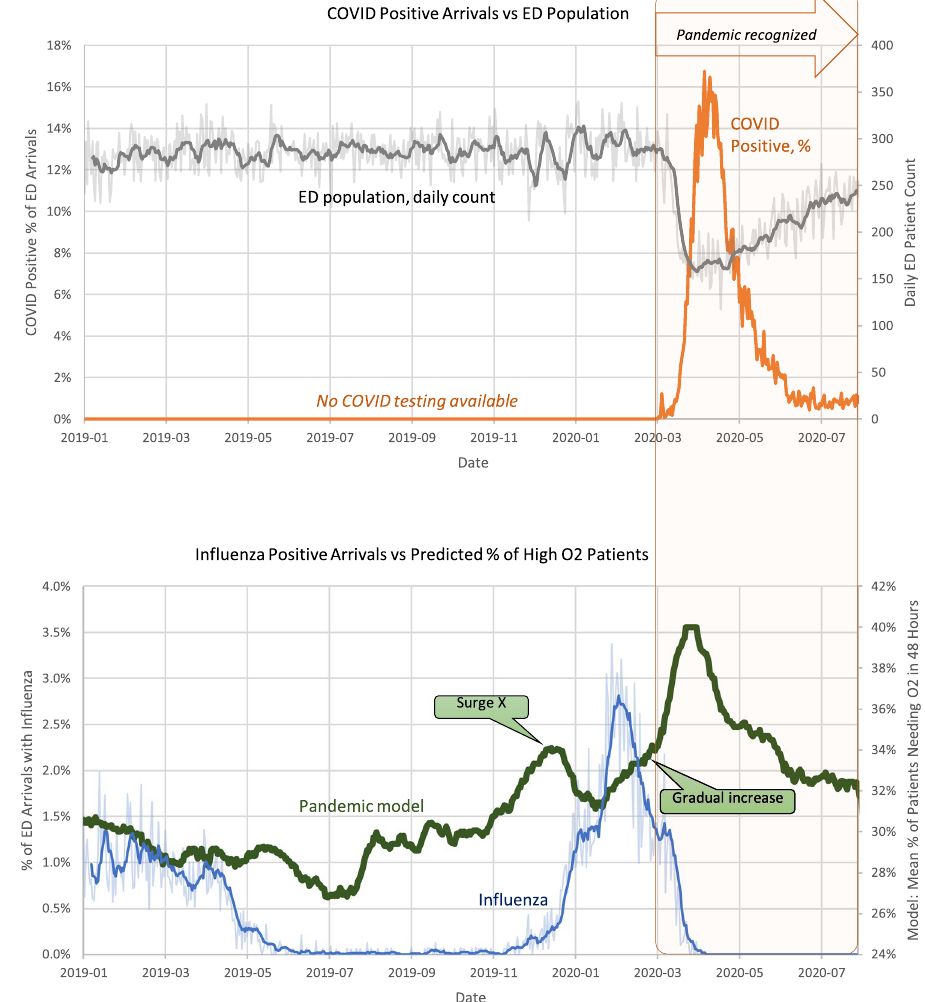
Figure 2. Top: Percentage of ED patients who had positive COVID-19 test results versus the daily ED population count; regular COVID-19 tests became available in March 2020. Bottom: Percentage of ED arrivals who received a positive influenza test versus our pandemic model trend. Darker lines show 1-week moving averages, and lighter background lines—the actual daily